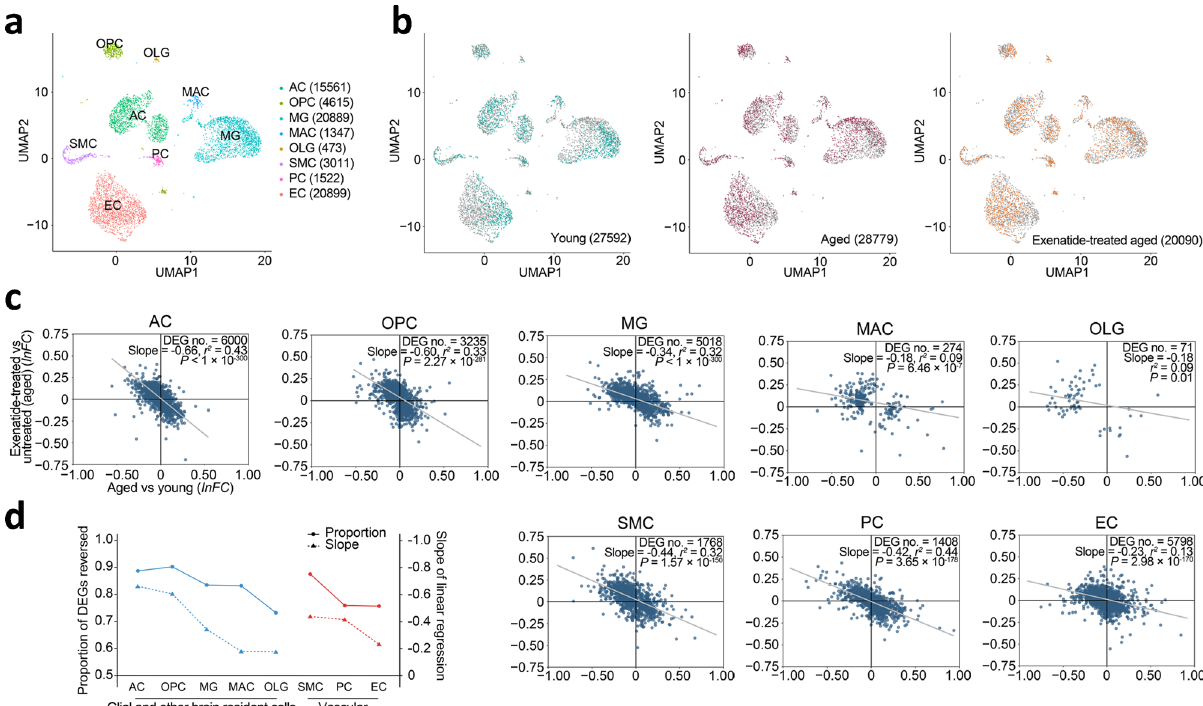
Fig. 1 Reversal of glial and neurovascular cell transcriptomic aging signatures by GLP-1RA treatment. a UMAP visualization of the major cell type clusters identi fi ed and analysed. Numbers in brackets: cell numbers for the respective cell types. AC astrocyte, OPC oligodendrocyte precursor cell, MG microglia, MAC perivascular macrophage, OLG oligodendrocyte, SMC smooth muscle cell, PC pericyte, EC endothelial cell. b UMAP visualization of the single-cell transcriptomes from young adult, aged, and GLP-1RA (exenatide)-treated aged mouse brains. For each plot, colored dots highlight cells from the respective labeled group, while gray dots are cells from the other groups. Numbers in brackets: cell numbers for the respective groups in the dataset ( n = 3 animals for each group). For clarity, 6000 cells were subsampled for visualization in each plot in a and b . c Age-related expression changes ( x -axis) plotted against post-exenatide treatment expression changes ( y -axis) in glial (AC, OPC, MG, and OLG), vascular (EC, PC, and SMC) cell types, and MAC. Each dot represents one differentially expressed gene (DEG). lnFC : natural log of fold change. Gray lines: lines of best fi t by linear regression. d Proportions of DEGs reversed and the slopes of lines of best fi t by linear regression shown in c in the different cell types. See Supplementary Data 1 for source data underlying ( c